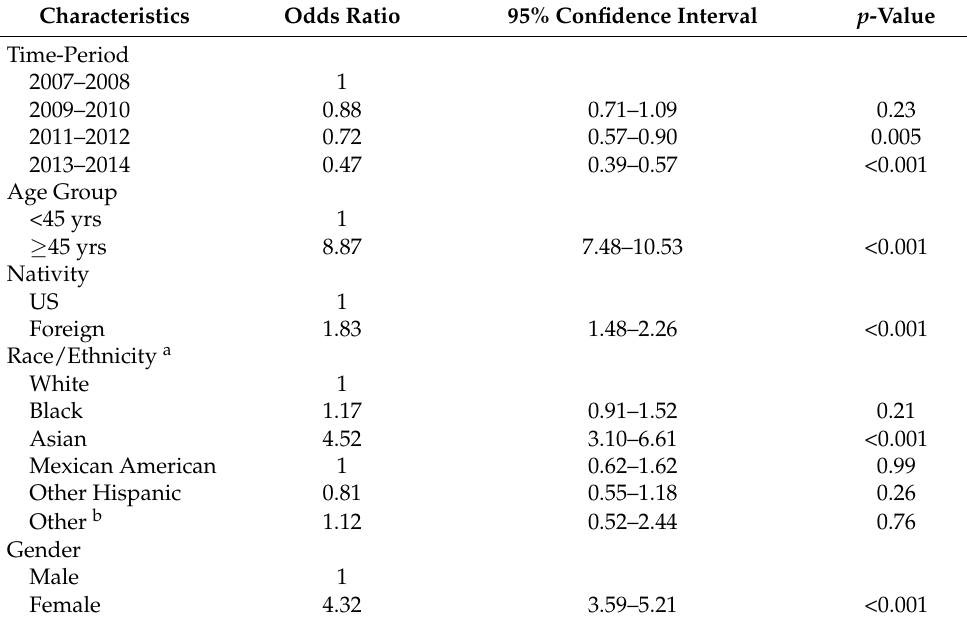
Table 3. Multivariate logistic regression on the likelihood of high exposure risk of urinary cadmium levels, ≥ 2 µ g/g, while adjusting for participant characteristics